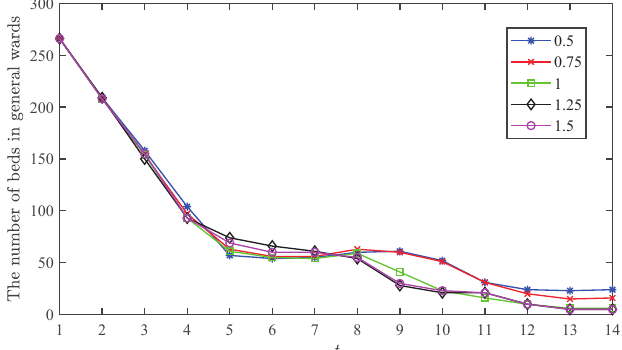
Figure 12. The number of beds in general wards in case 2.